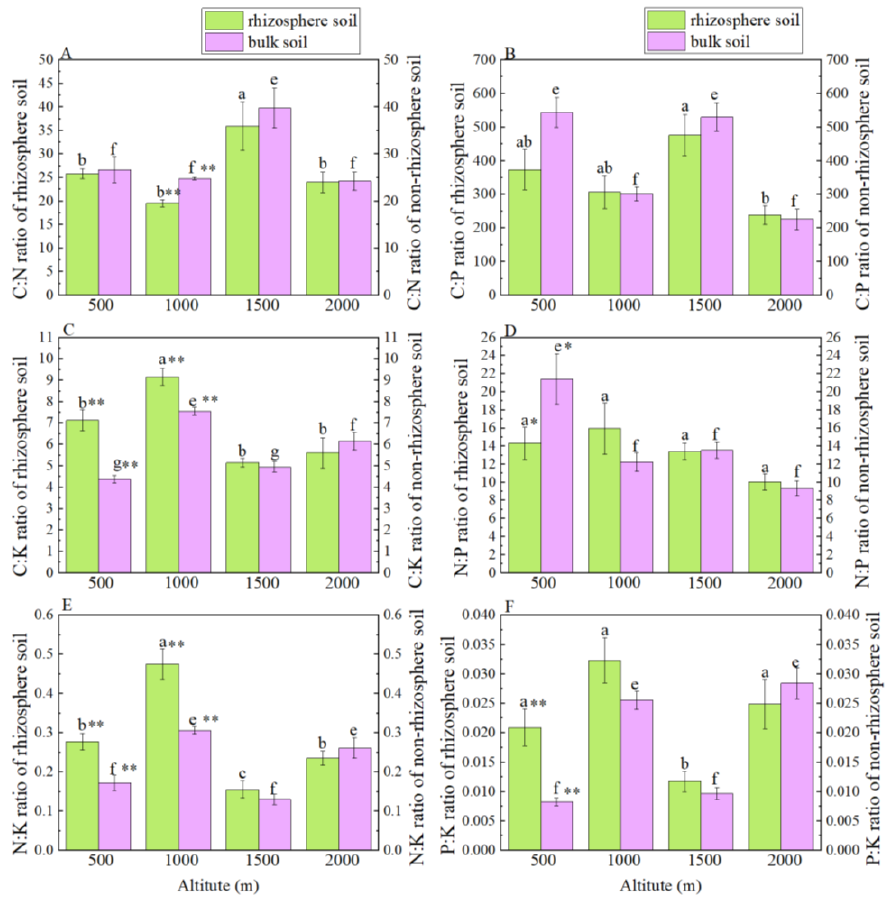
Figure 3. C, N, P and K stoichiometric indexes of rhizosphere and bulk soils of Smilax china L. at different altitudes: ( A ), C:N ratio of rhizosphere and bulk soils; ( B ), C:P ratio of of rhizosphere and bulk soils; ( C ), C:K ratio of rhizosphere and bulk soils; ( D ), N:P ratio of rhizosphere and bulk soils; ( E ), N:K ratio of rhizosphere and bulk soils; ( F ), P:K ratio of rhizosphere and bulk soils; different lowercase letters (a–c) indicate significant differences at p < 0.05 among rhizosphere soils at different altitudes; different lowercase letters (e–g) indicate significant differences at p < 0.05 among bulk soils at different altitudes; * and ** indicate significant differences between rhizosphere and bulk soils at the same altitude at p < 0.05, p < 0.01,